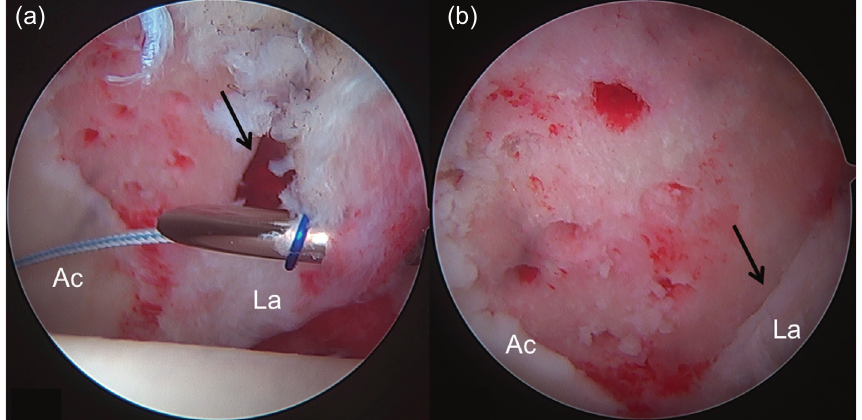
Figure 5. Once the microfractures are completed in the acetabulum (Ac) and the acetabular resection osteoplasty is performed, the acetabular labrum (La) must be repaired. This is important since it is the only option to transform this open lesion at the chondrolabral rim (a, arrow) into a contained defect. In this case, a translabral suture (a) was used to fix the labrum to the acetabular ridge. Once the suture was completed, a suitable apposition of the labrum on the edge of the lesion can be observed (b, arrow) sealing the limit of the chondral lesion. This allows a better containment of the clot generated in the area of the chondral lesion treated by the